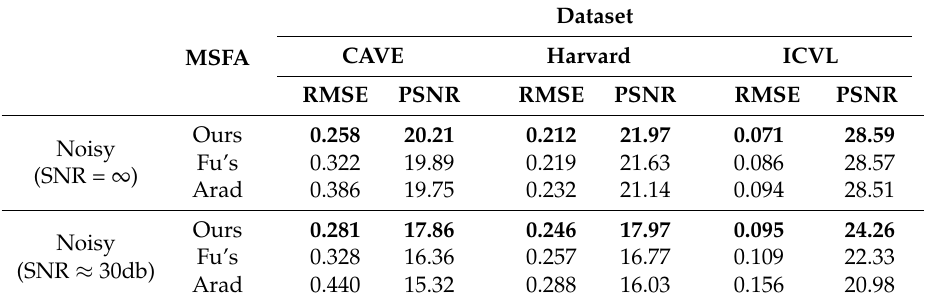
Table 2. Quantitative evaluation of the sparse reconstructions using Fu’s, Arad’s and our MSFA (see Figure 7) on synthetic datasets. Note that the bold font indicates the minimal error.